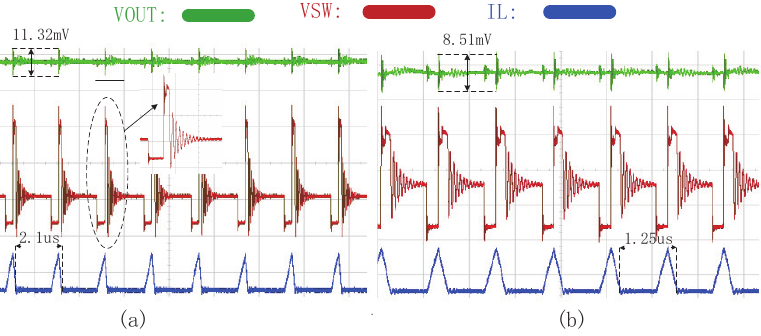
Figure 12. Test results of V OUT , V SW , I SW in PCMC-PFM operating mode of the proposed DCDC Boost converter. ( a ) When the I load is 50 mA. ( b ) When the I load is 100 mA. Figure 14a–d show the results of the load conversion response test results of the boost converter. In Figure 14a, the load is switched from 10 mA to 50 mA and the converter is switched from DGM mode to PFM mode with a response time of 30.3 µ s. The switching within the PFM mode is shown in Figure 14b, where the load is switched from 50 mA to 100 mA with a response time of 28.1 µ s. The test results shown in Figure 14c,d are for switching from PFM mode to PWM mode. In Figure 14c, the load current is switched from 100 mA to 200 mA with a response time of 18.5 µ s. In Figure 14d, the load current is switched from 50 mA to 250 mA with a response time of 40.8 µ s.